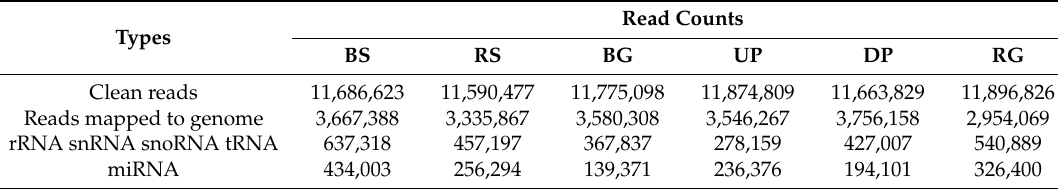
Table 2. Statistical analysis of sequencing reads for six sRNA libraries. BS, branch tips of Fuji; RS, root tips of M9; BG, branch tips and RG, root tips of 10 cm above the graft union (UP); DP, phloem of 10 cm below the graft